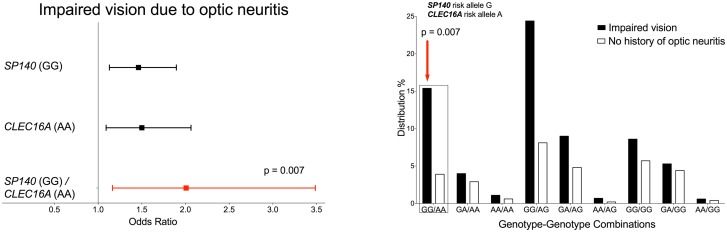
Forest Plot and genotype-genotype distributions for the significantly associated combination with visual impairment.Left-hand side: Forest plot showing the odds ratio (OR; incl. 95% C.I.) for the significantly with visual impairment associated genotype-genotype combination, including the contributing single genotype ORs. The lead genotype-genotype combination has been listed and colored in red for OR>1. The contributing genotype is stated in brackets behind the corresponding heading gene name. On the right handed side the percentage distribution of each genotype-genotype combination in the given cohort is presented as a bar chart. The significantly associated genotype-genotype combination from the left handed graphic is highlighted via frame and colored arrow; red = OR>1.